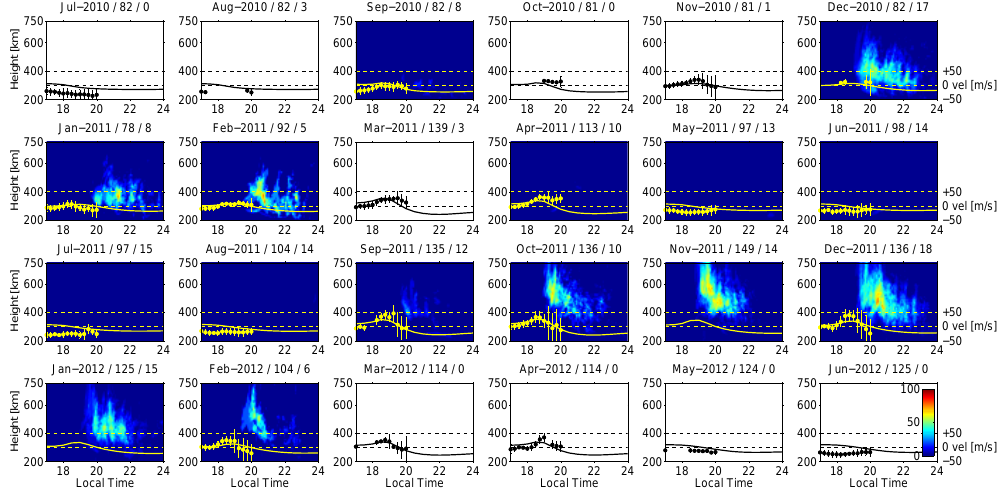
Figure 4. Monthly occurrence of F region echoes observed by the São Luis radar. Blank panels indicate months when ESF measurements were not made (radar did not operate) or less than five nights of observations were available. Mean F region vertical drifts are also shown for each month. Measured drifts are shown as markers. Model drifts are shown as solid lines. The dashed lines indicate − 50, 0, and − 50ms − 1 drifts. The results of our analysis are presented in Fig. 5, which shows the scatter plot of the mean vertical drifts versus top- side echo occurrence rate. Scatter plots are shown for vertical drifts measured within the four different local time windows. The horizontal bars represent the standard deviation of the drift values used to compute the averages. Figure 5 shows that negative mean drifts are good precursors of the absence of topside ESF. Topside structures were not observed for cases of negative drifts occurring around 18:00 or 18:30